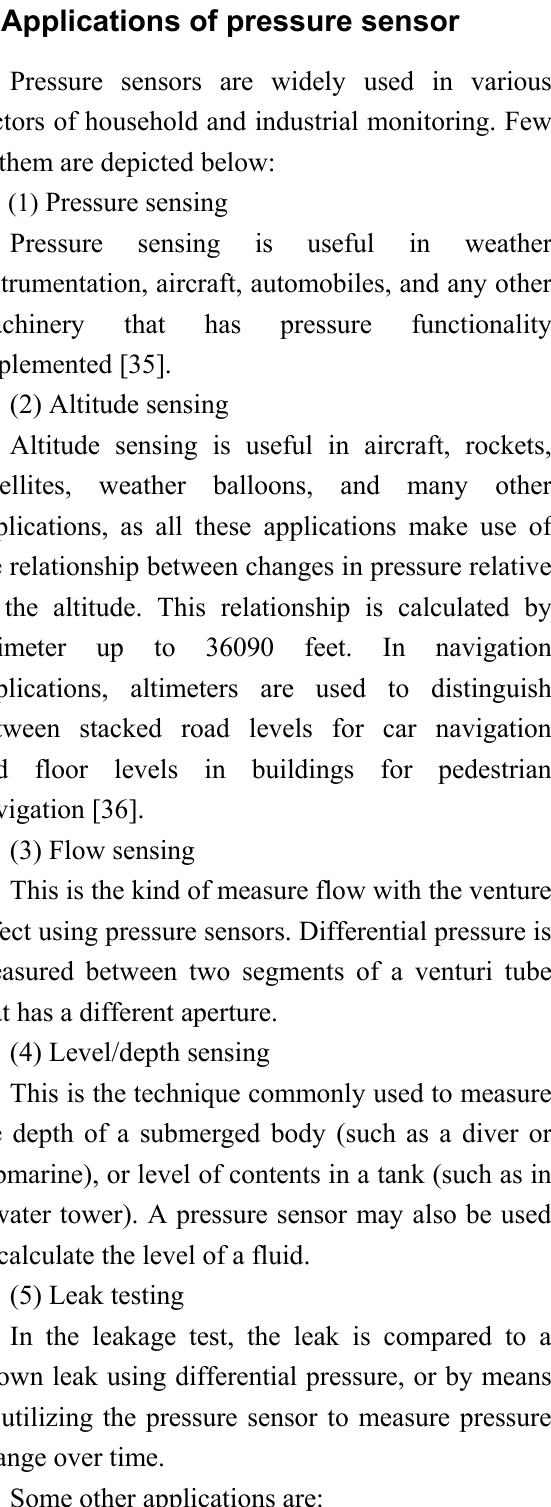
Fig. 10 Block diagram of piezo-optic pressure